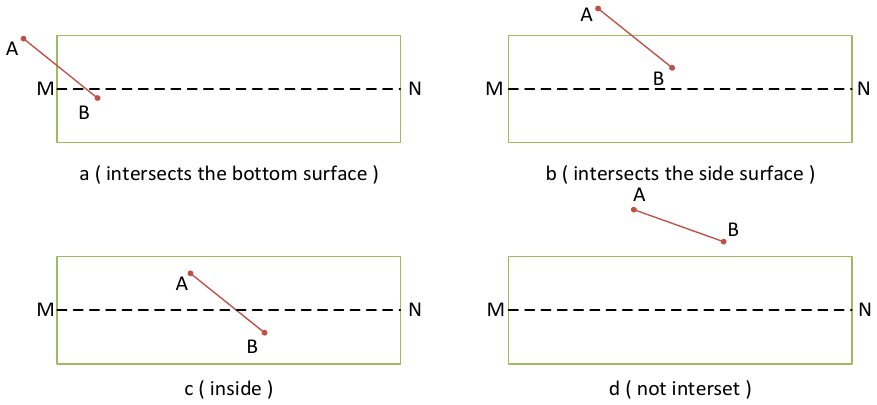
Figure 8. Diagram of the Intersection Detection of a Line Segment and a Cylinder. (4) Intersection of a line segment and a capsule